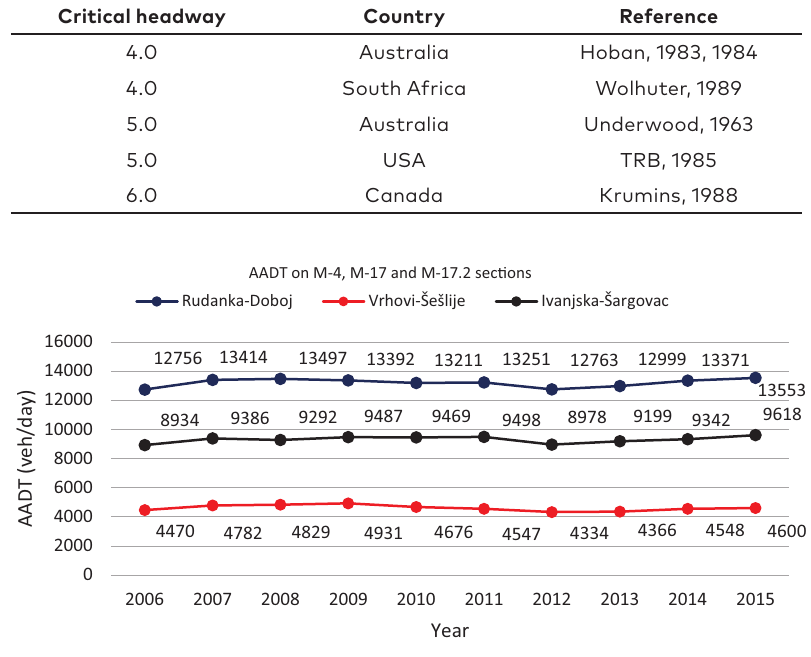
Figure 2. AADT on measurement sections of two-lane